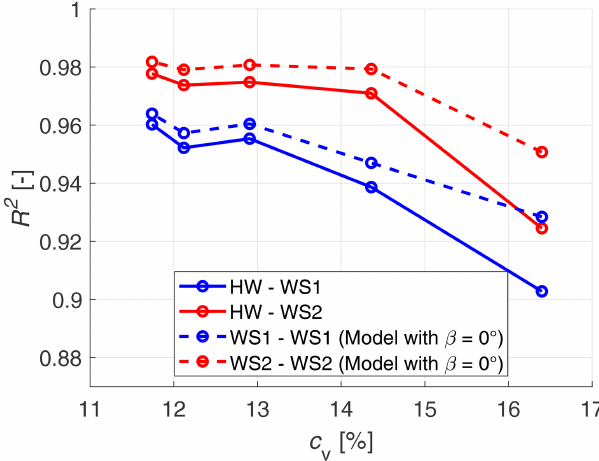
Figure 25. Correlation between WindScanner and hot-wire time se- ries (solid lines) and between modelled and actual WindScanner time series (dashed lines), as a function of the coefficient of varia-